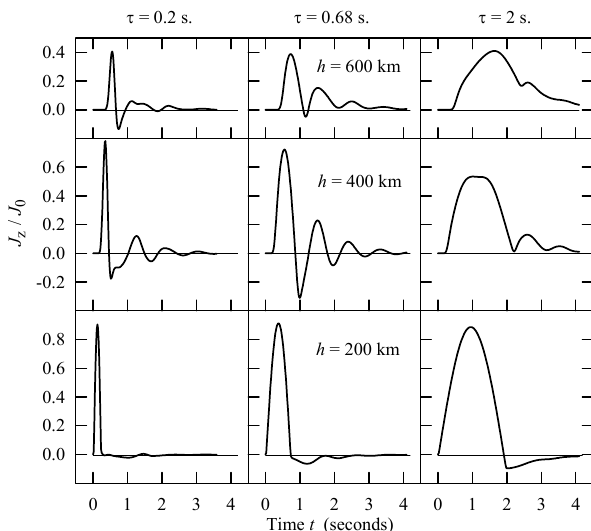
Fig. 2. Dependence on time t of relative values of the Alfv´en wave field-aligned current J z / J 0 at three fixed heights h for the emitted pulse durations τ =0.2, 0.68, and 2s. Time is measured from turn on of the pulse